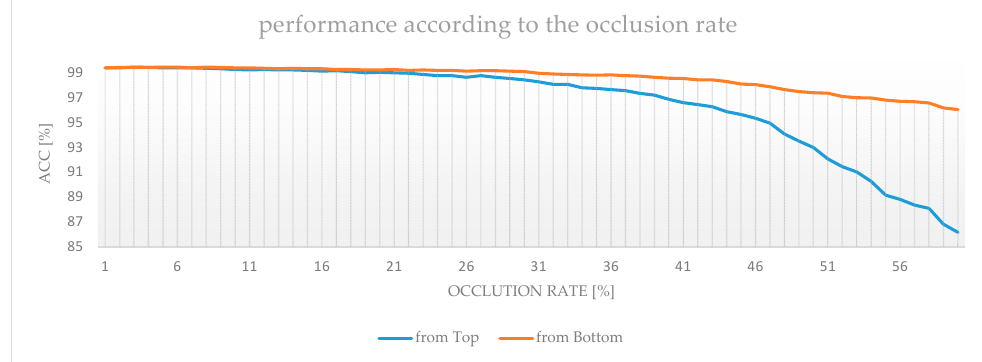
Figure 3. Changes in verification performance according to the occlusion rate.